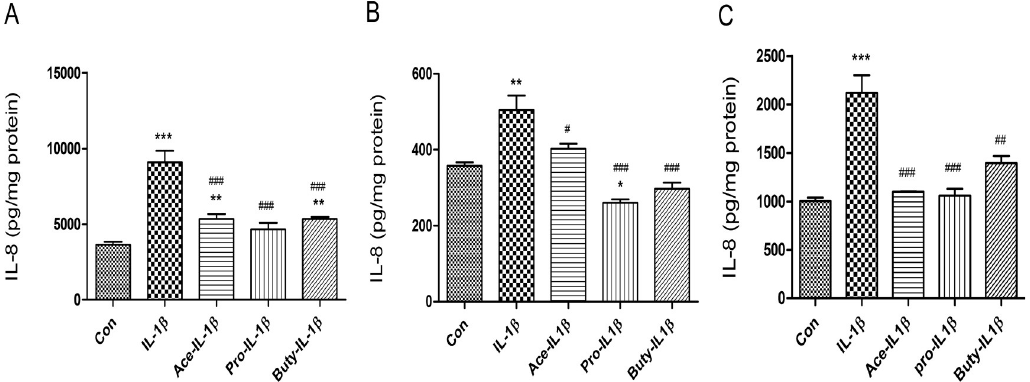
Fig 2. SCFA inhibited IL-1 β induced IL-8 secretion in H4 organoids and other fetal human intestinal organoids. H4 organoids (A), and fetal human small intestinal organoids from gestational age 15-week (B) and 22-week (C) cultured as a monolayer in trans-well plates were pretreated with 20 mM of acetate, propionate or butyrate for 30 min before IL-1 β stimulation (1ng/ml for 24h). The secretion of IL-8 into the supernatants was measured by Elisa. Data are represented as the mean ± SEM of three independent experiments. One -way ANOVA and Tukey post hoc tests were used for statistic, n = 3. Differences compared to the control group were considered significant at � p < 0.05, �� p < 0.01, ��� p < 0.001; differences compared to the IL-1 β group were considered significant at # p < 0.05, ### p <